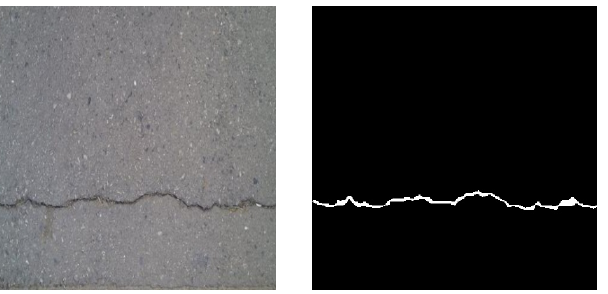
Figure 4. An example of the crack images. ( Left ) image. ( Right ) ground truth.